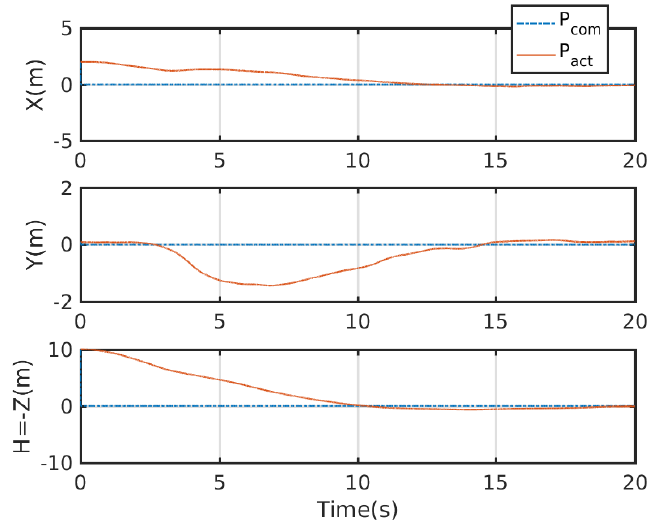
Figure 4. Overall position evolution of the IAP.